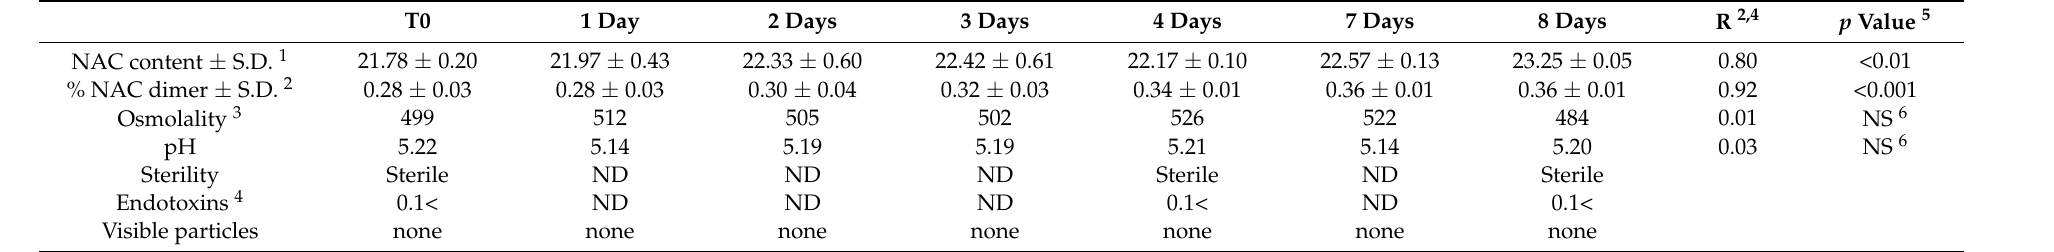
Table 7. NAC + 62.5 µ g · mL − 1 zinc gluconate stability study, 5 ± 3 ◦ C storage conditions. T0